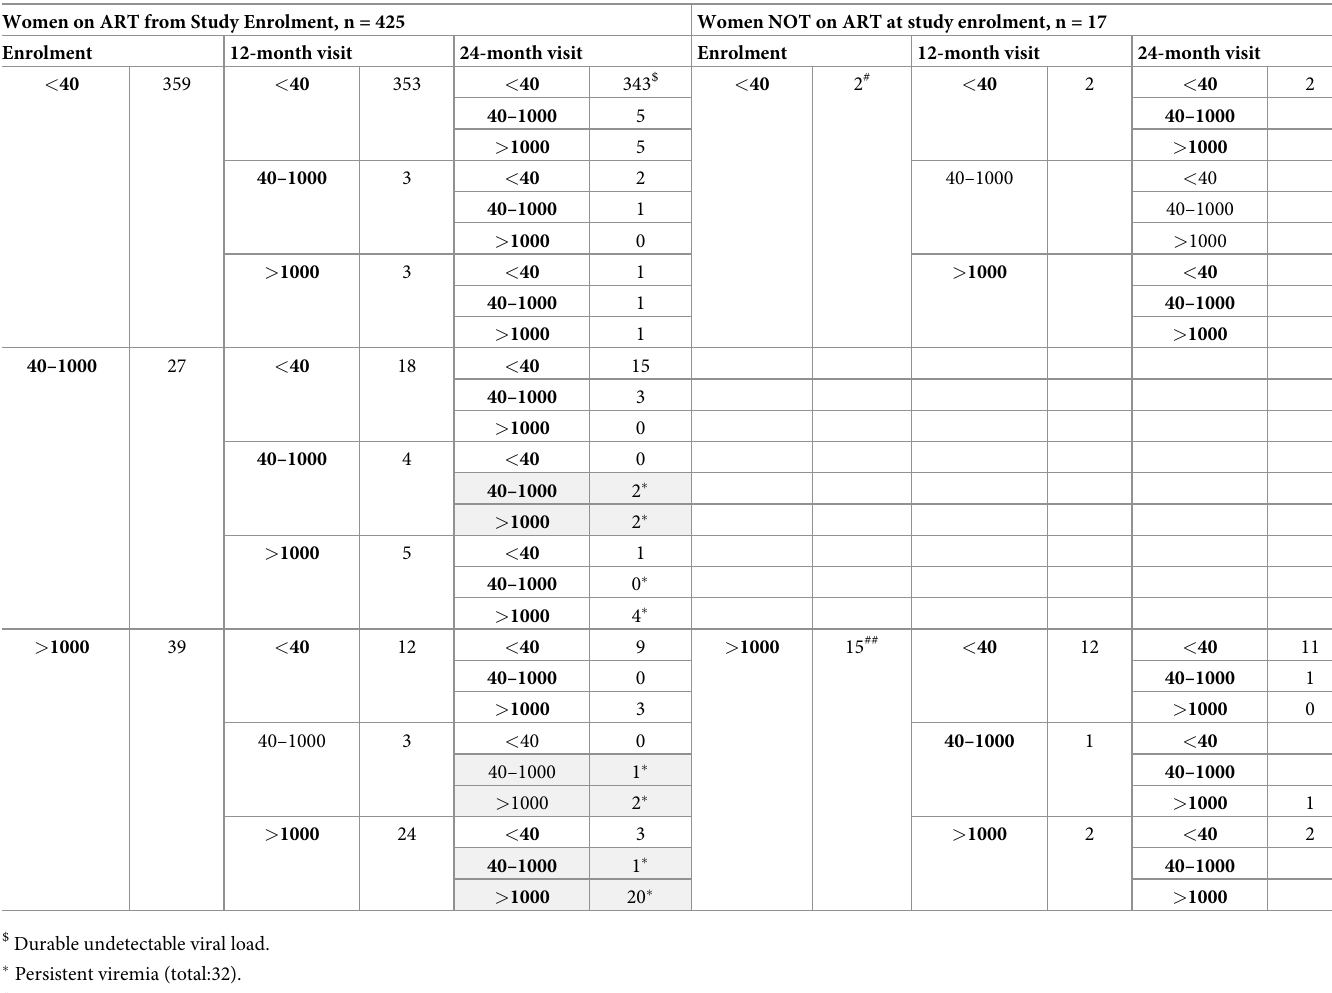
Table 3. Viral load trends among women with complete viral load